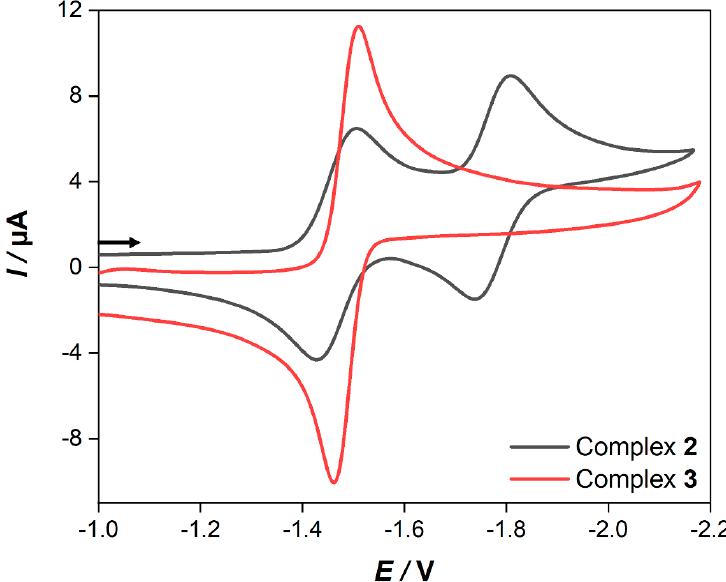
Figure 4. Cyclic voltammetry of 1.0 mM solutions of complexes 2 and 3 in CH 2 Cl 2 − [ n − Bu 4 N][BF 4 ] (0.1 M) registered at a 0.2 V/s scan rate. The arrow indicates the scan direction. The potentials E are given in V and are referenced to the Fc + /Fc couple.